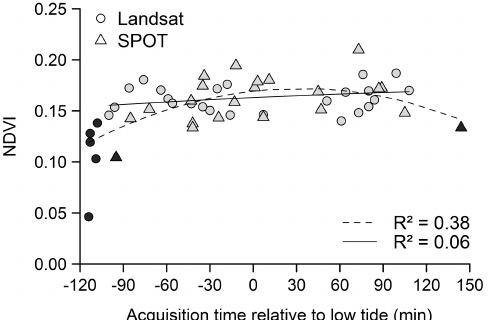
Figure 5. NDVI extracted from a transect going through the two oyster reefs (see Fig. 2) based on satellite data acquired before the burning (1985–2014 time series, mean ± 95% CI, n = 33). Black vertical bars correspond to the location of the